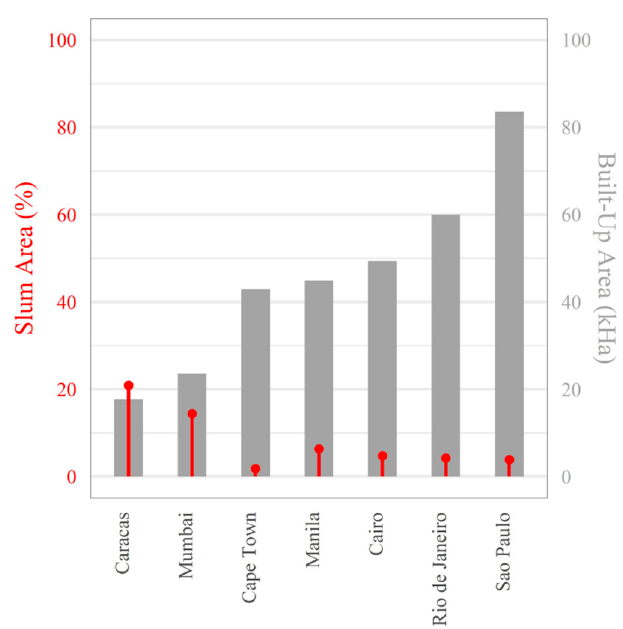
Figure 7. Grey: Built-up area in thousand hectare (kHa); Red: Share of slums in percentage per city surveyed.